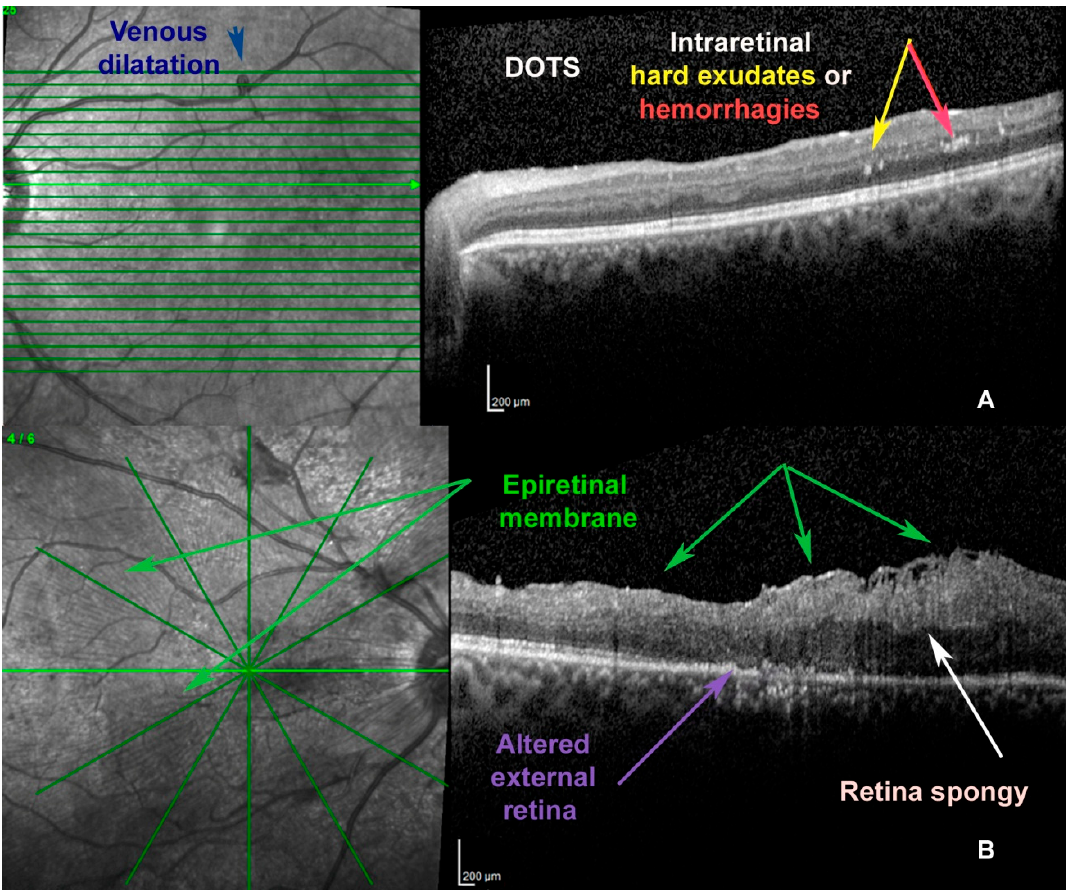
Figure 1. Spectral-domain optical coherence tomography exam of two patients. Patient ( A ). Initial diabetic retinopathy (DR) characterized by typical vascular and retinal abnormalities: microaneurysms, hemorrhages (hyperreflective dots), hard exudates (hyperreflective dots), and venous dilatation (blue arrow). Patient ( B ). Preproliferating ischemic-exudative DR to the posterior pole with epiretinal membrane (green arrows), retina spongy (white arrow), and altered layers of photoreceptors and retinal pigment epithelium (external retina).